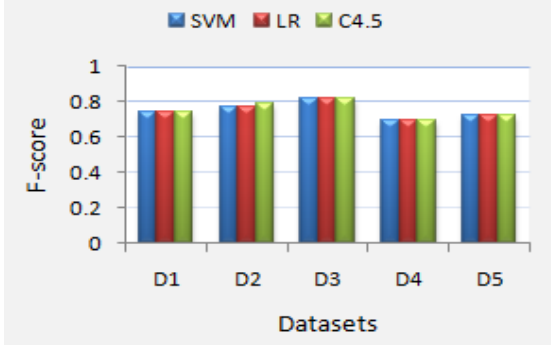
Figure 1. Prediction results of machine learning techniques in terms of F-Score for different datasets based on temporal and spatial contexts.